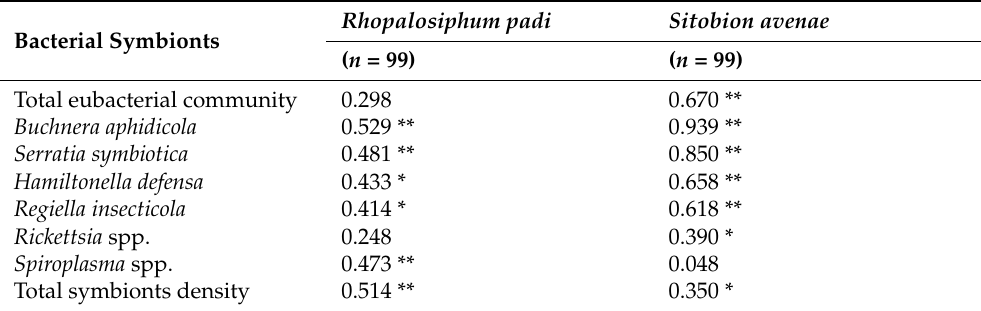
Table 2. Correlation among the critical thermal maxima (CTmax) of cereal aphids with their bacterial symbiont gene